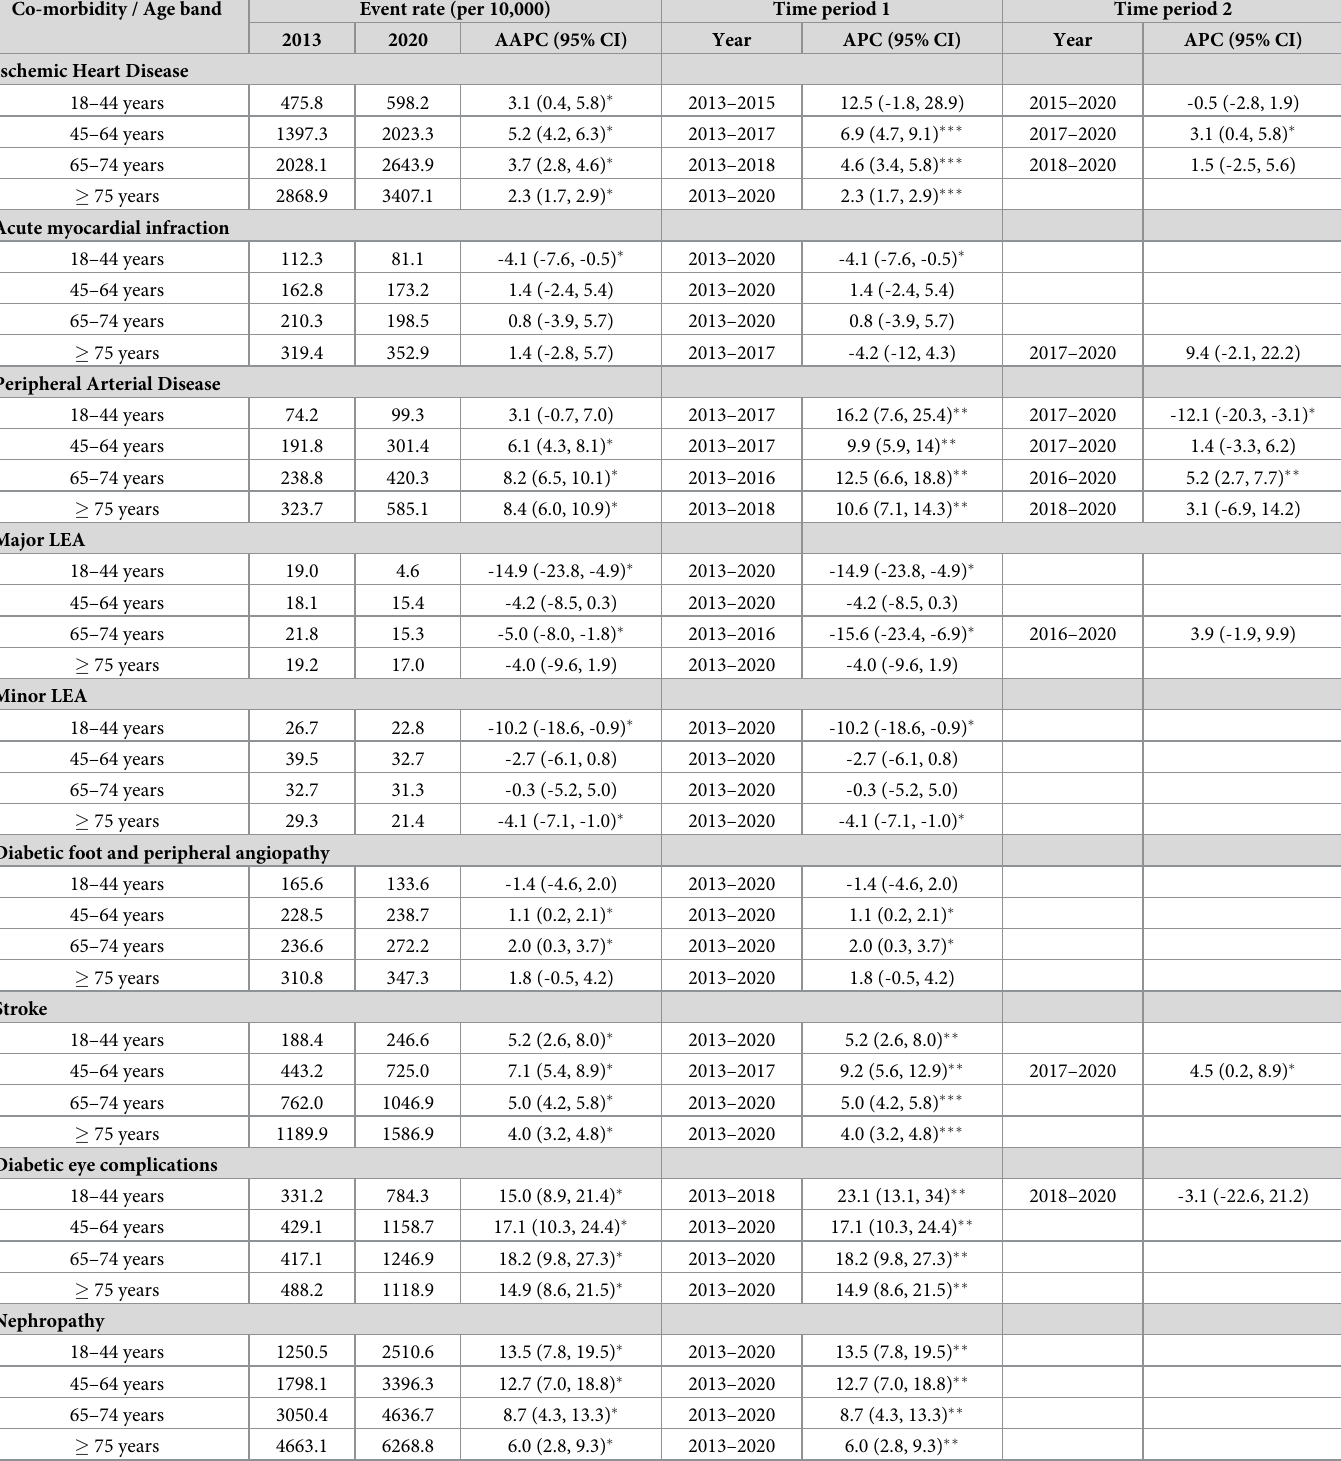
Table 3. Joinpoint analysis of trends in event rates of diabetes-related complications by